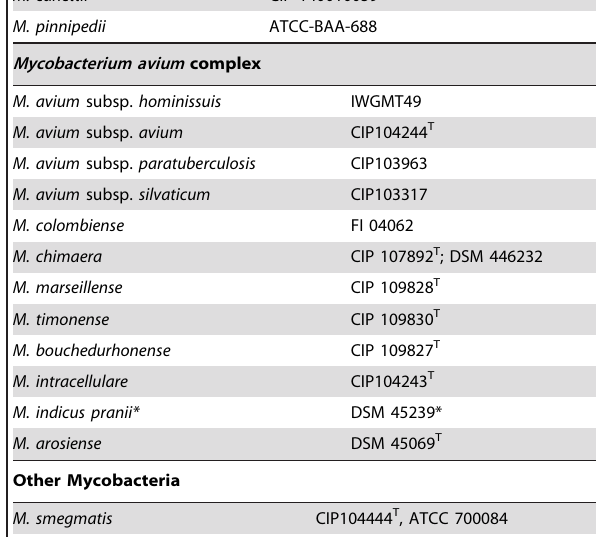
Table 1. Reference mycobacteria strains used to create a MALDI-TOF MS database for the identification of